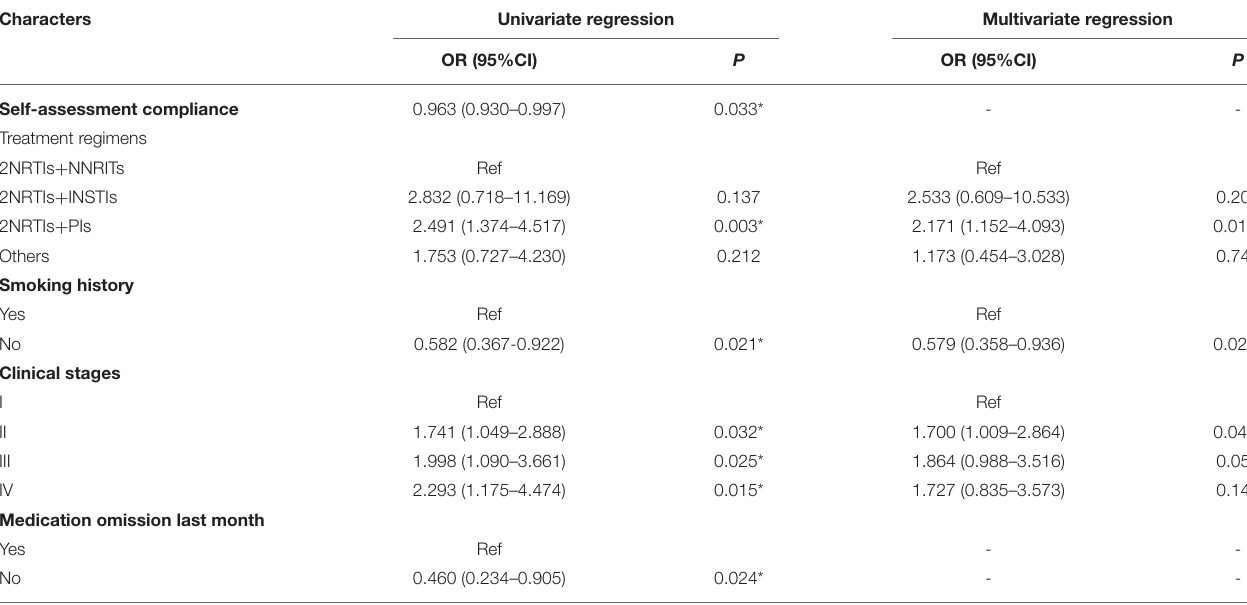
TABLE 6 | Factors associated with treatment effect among HIV/AIDS